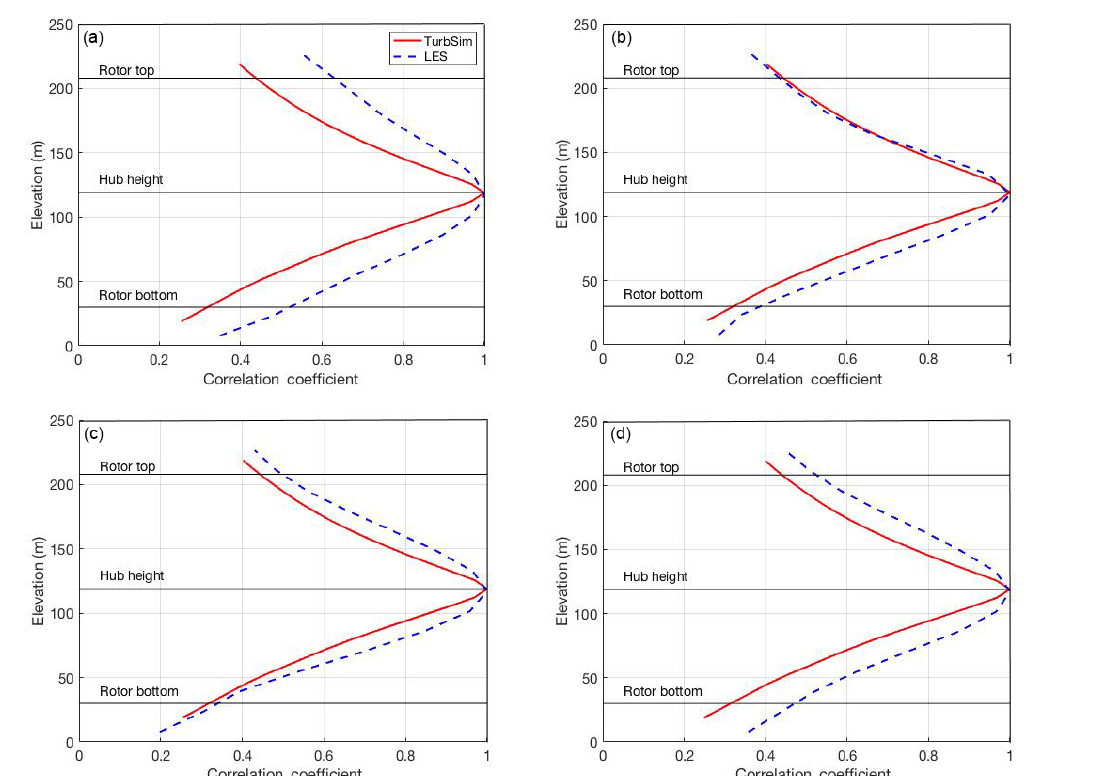
Figure 7. Profiles of the correlation coefficient between the 10min horizontal wind speed time series at each elevation and the 10min horizontal wind speed time series at hub height for TurbSim (red) and LES (blue dashed) simulations at four different radii from the hurricane